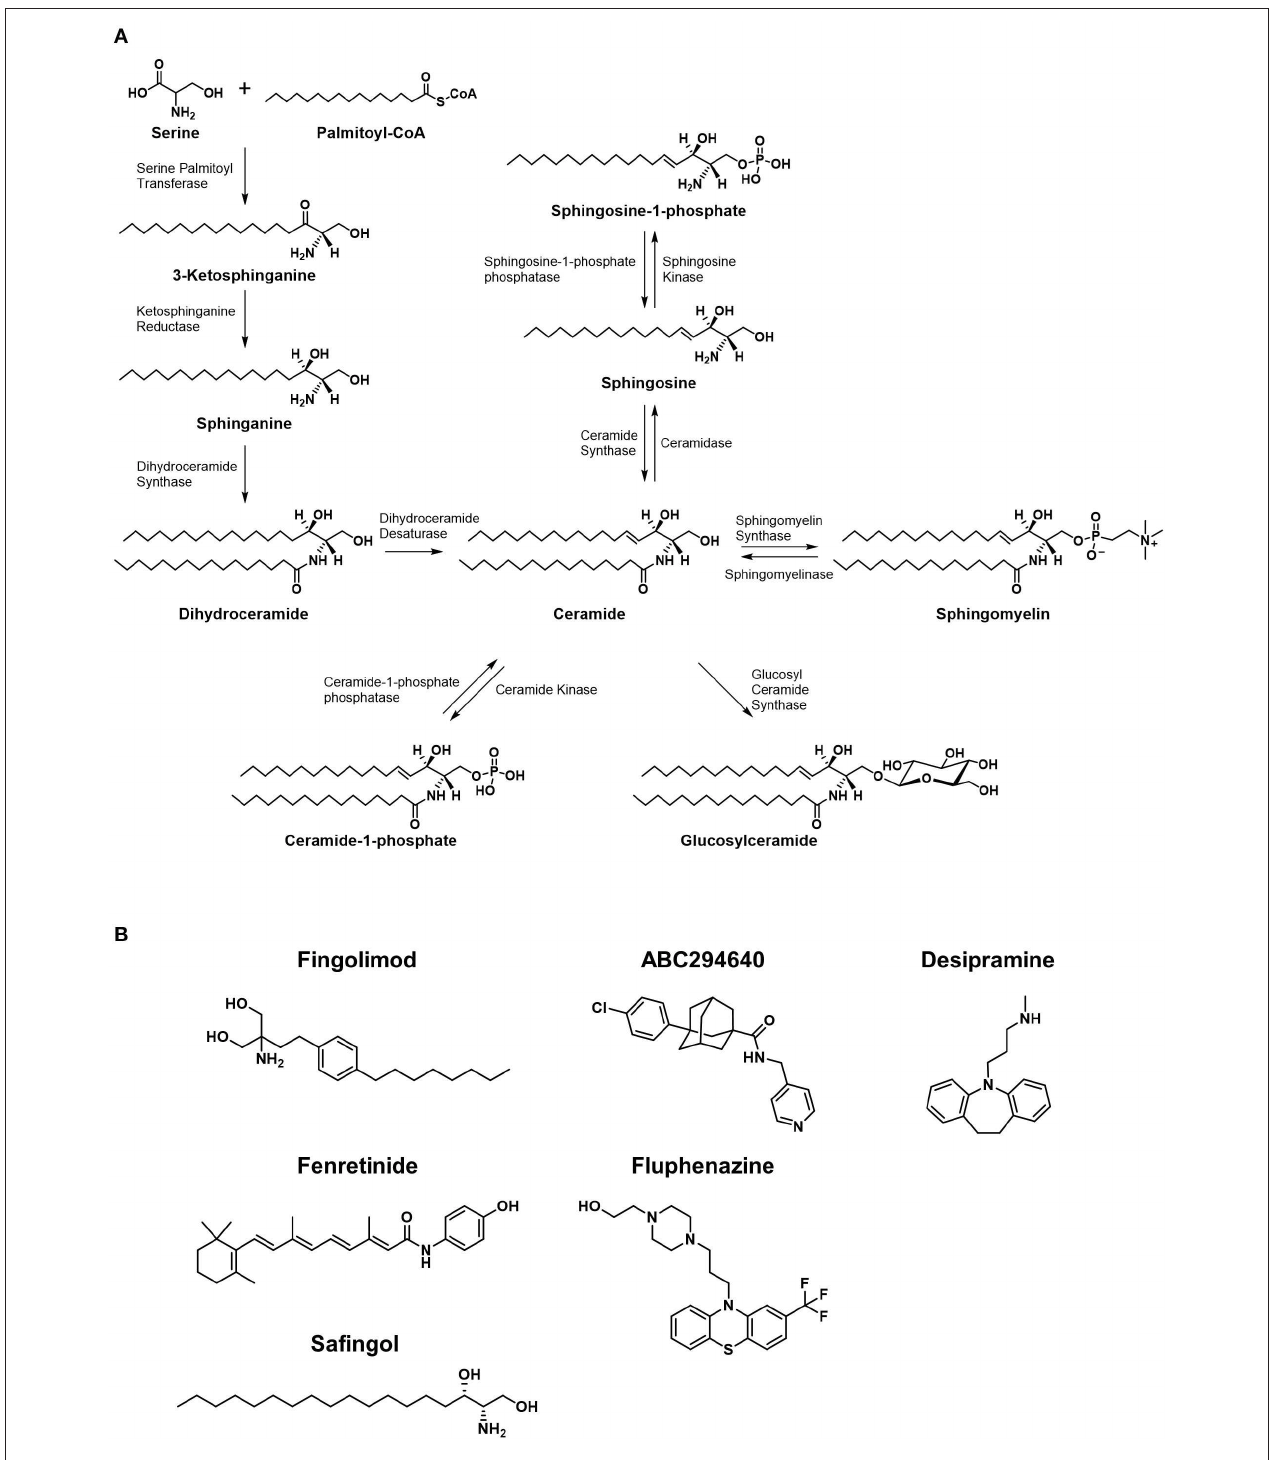
FIGURE 2 | Metabolic pathways of sphingolipids and chemical structures of inhibitors of the pathways. (A) Major synthetic and metabolic pathways of sphingolipids. Increased ceramide leading to cytotoxicty comes from de novo synthesis resulted from stimulation of serine palmitoyltransferase and/or dihydroceramide synthase, or by degradation of sphingomyelins via spingomyelinases. The formation of ceramide-1-phosphate or glucosylceramide is considered shunting pathways to less toxic forms of sphingolipids. (B) The structures of small molecules that are currently under clinical investigation in cancer patients are shown.